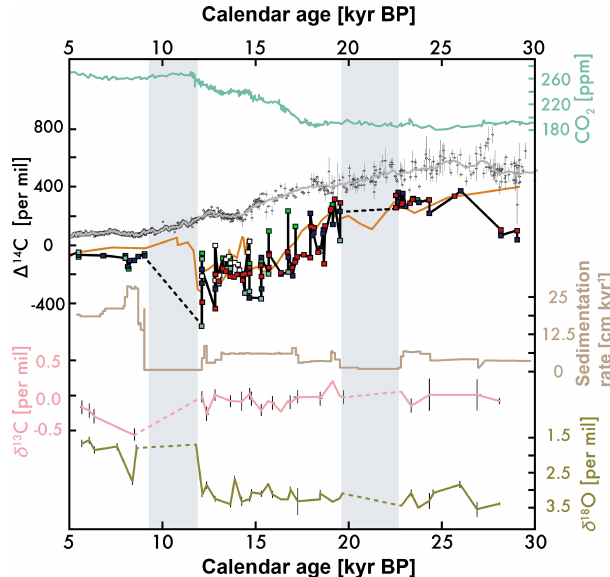
Figure 7. From top to bottom: atmospheric carbon dioxide (CO 2 ) (blue; same as Fig. 1), atmospheric CO 2 (cid:49) 14 C (gray; same as Fig. 1), mixed and monospecies benthic foraminifera (cid:49) 14 C from the California Undercurrent site (orange) (Lindsay et al., 2015; Marchitto et al., 2007), all monospecies benthic foraminifera (cid:49) 14 C from near the mouth of the Gulf of California (black), sedimenta- tion rate of LPAZ-21P (see Fig. 3), alongside benthic foraminifera P. ariminensis δ 13 C (pink) and δ 18 O (green) from this study and Herguera et al.